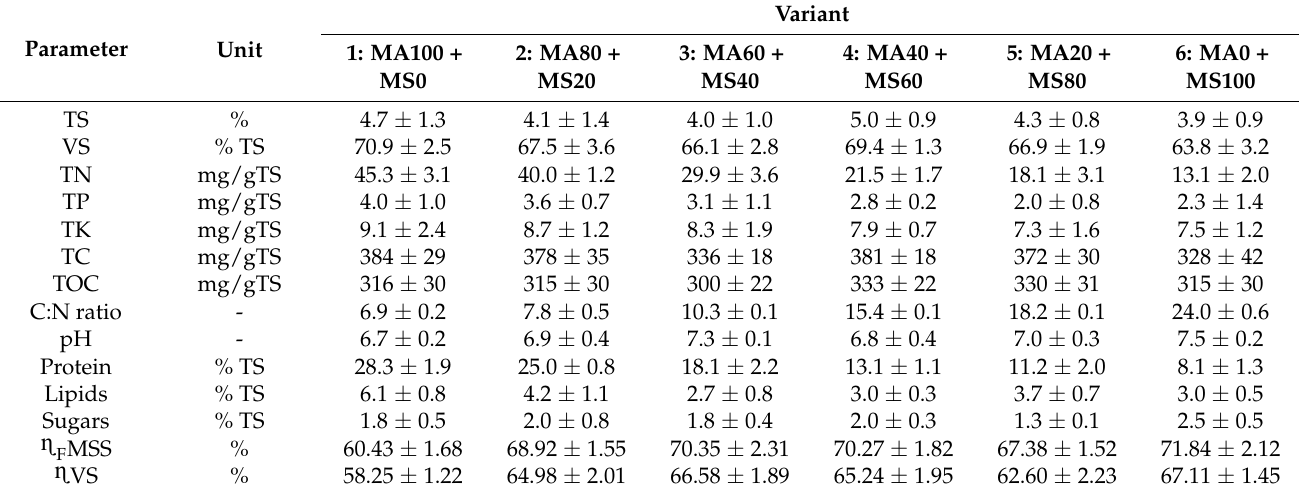
Table 5. Digestate parameters across the experimental